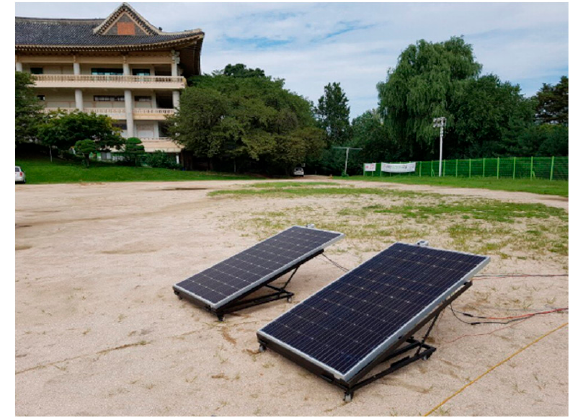
Figure 8. Site and environment for experiment on the ground.